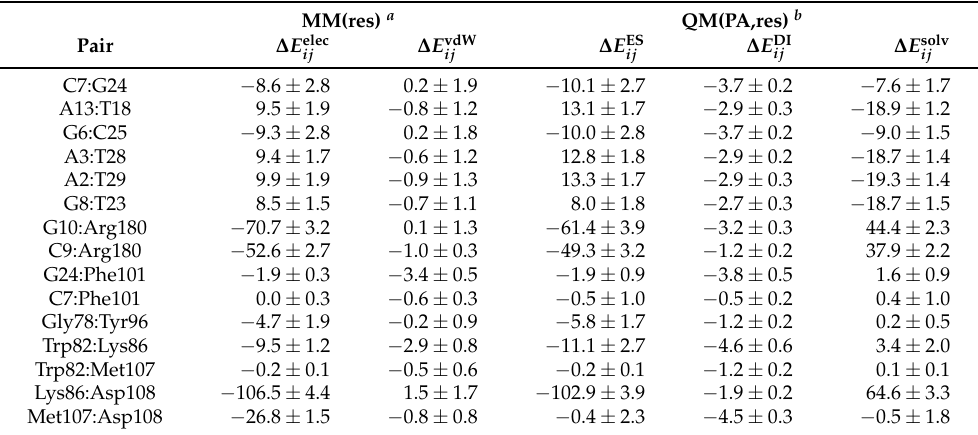
Table 3. Components of pair interaction energies (kcal mol − 1 ) in the protein–DNA complex, averaged over 100 snapshots of the MD